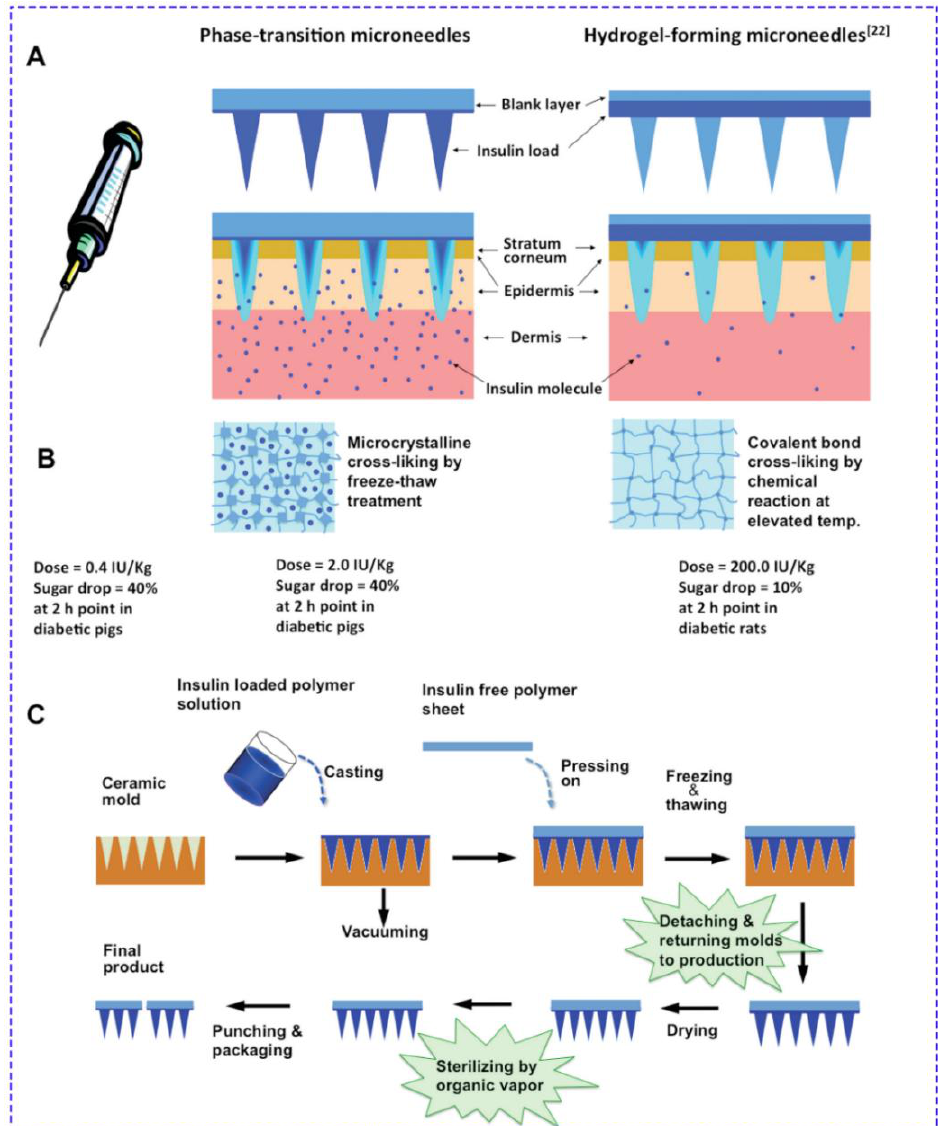
Figure 6. Fabrication process of phase transition patches. ( A ) The MNs absorb the interstitial fluid (IF) from the dermis layer to convert from a hard, glassy state to a hydrogel state to allow the preloaded insulin to release to the bodily fluid in the dermis layer. ( B ) The microneedle matrix of phase-transition microneedles (PTM) is cross-linked through microcrystalline domains as the cross-linking junctions via a freeze–thaw treatment to avoid dissolution, while that of hydrogel forming is cross-linked through covalent bands as the cross-linking junctions via a chemical reaction. Therefore, insulin can be loaded in the needle tips of PTM to achieve a relative bioavailability of 20%, while insulin has to be loaded at the back of the microneedle array of hydrogel-forming microneedles (HFMs), leading to a bioavailability of less than 1% due to the extended di ff usion pathway. ( C ) The PTM patch may be fabricated using a scalable process comprising a sequence of simple unit operations involving the circulation of the molds in the production line and sterilization of the final product by steaming in oxirane vapor. Reprinted with permission from [122].